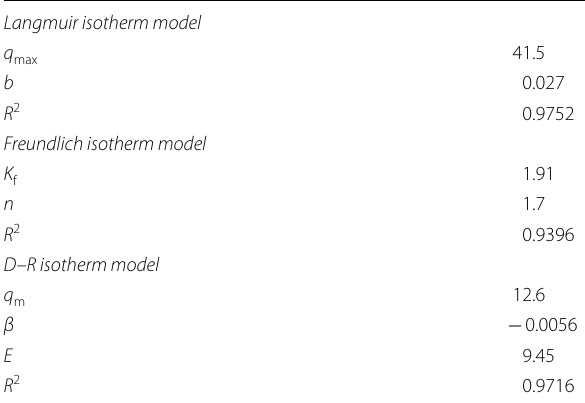
Table 4 Isotherm parameters for Cd(II) ions adsorption onto BTW Langmuir isotherm model